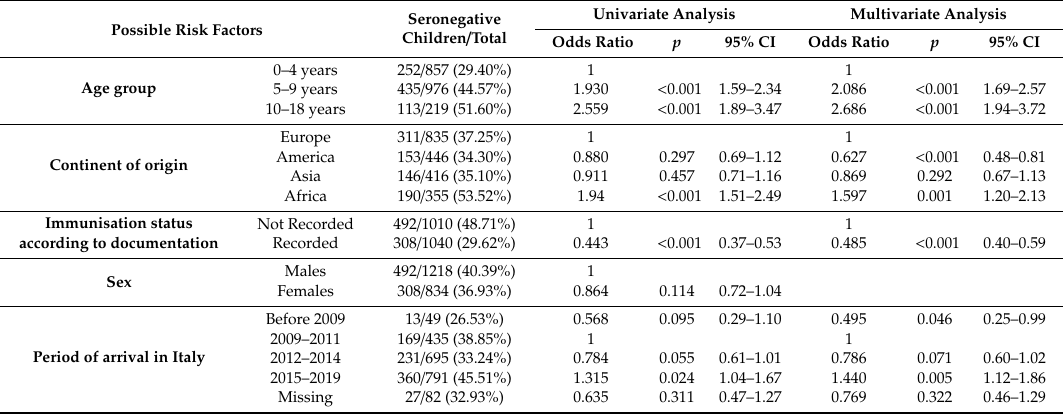
TableA10. UnivariateandmultivariateanalysesforfactorsassociatedwithseronegativityforhepatitisB. Possible Risk